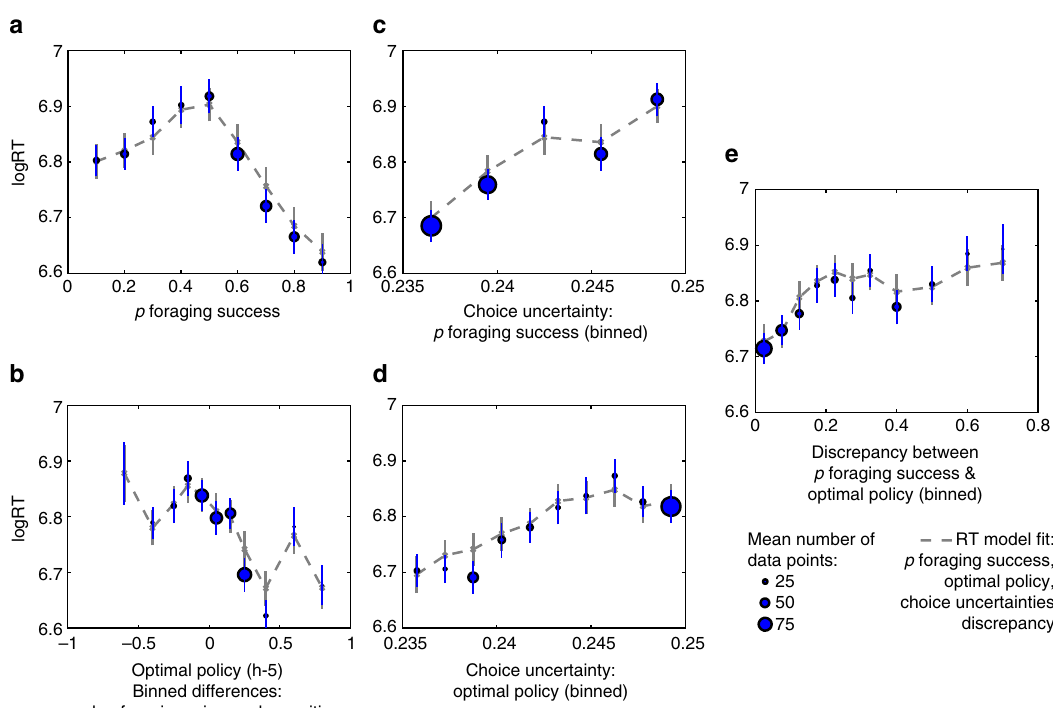
Fig. 5 Reaction time data and models of the fMRI sample. We tested the relationship between RTs and variables associated with the heuristic and optimal policies. Since the probability of foraging success emerged as the best predictor of participants ’ choices, we only included this but not any other heuristic in the model of RT data. RTs relate to a the probability of foraging success and also weakly to b the optimal policy. Importantly, RTs become slower with c , d increasing choice uncertainties of these two variables and e higher discrepancies in their prescriptions. Posterior predictive checks show that RT data were well captured by a model that includes the fi ve depicted variables. Error bars are SEM. Per data bin, circles depict mean empirical data points and lines and crosses depict mean model predictions (averaged for simulated data according to each participant ’ s model fi t). Circles scale with the average number of trials contributing to the respective data points. See Supplementary Fig. 13 for the behavioral sample, Supplementary Fig. 6 for the parameter estimates of the full RT model, and Supplementary Fig. 7 for posterior predictive checks of the RT model with data split differently. See Supplementary Table 6